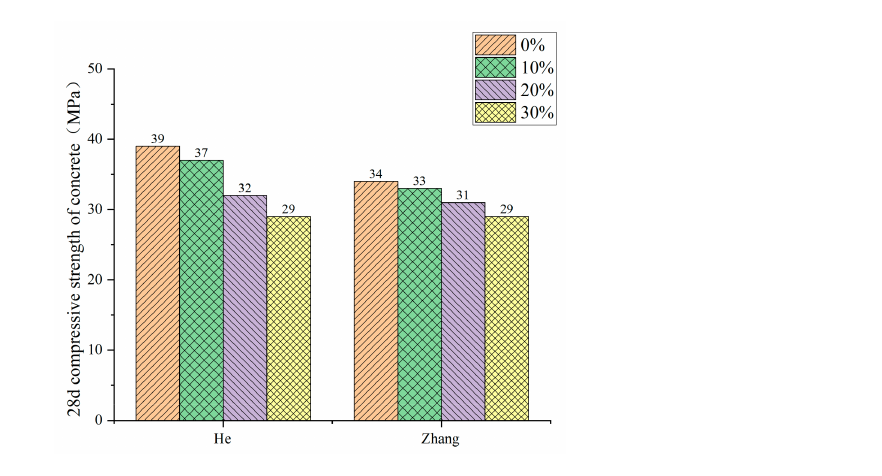
Figure 12. Compressive strength of concrete under different replacement ratios of RP [76,77].